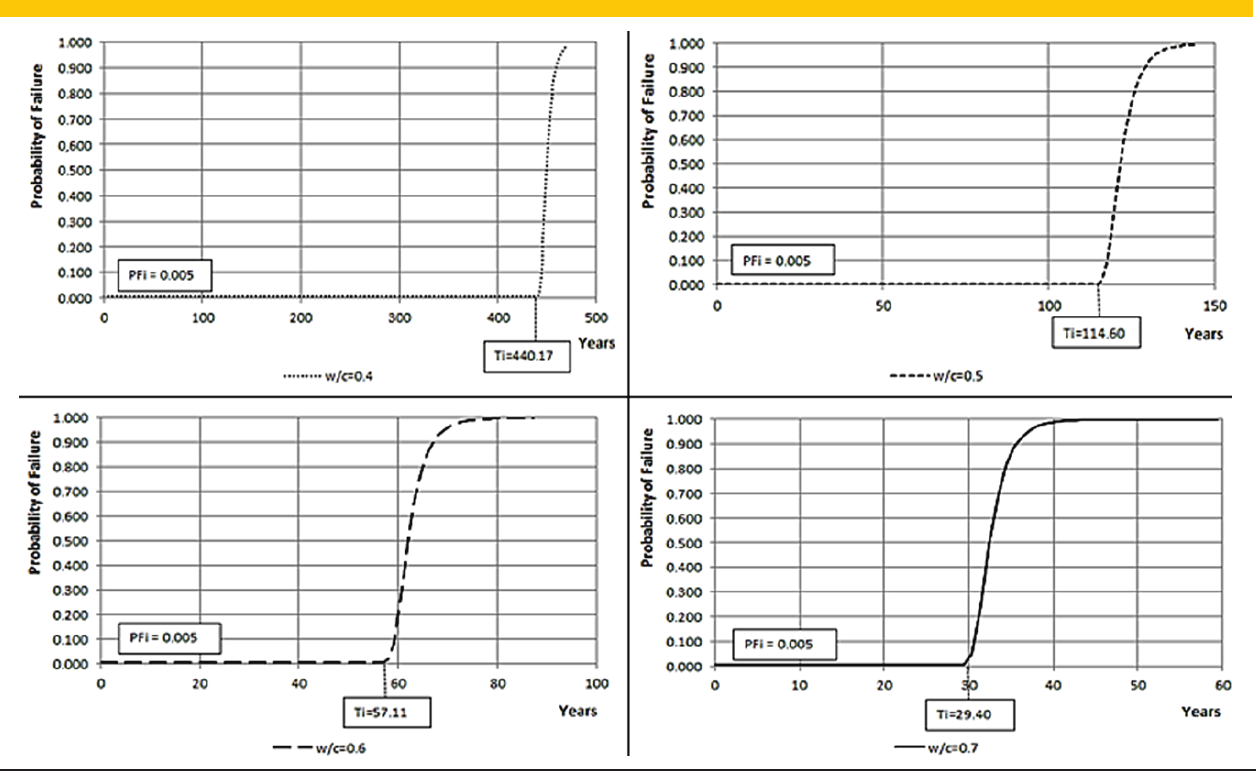
Figure 19 – Probability of failure along time for CA II and β x=0.628 single reinforcements'